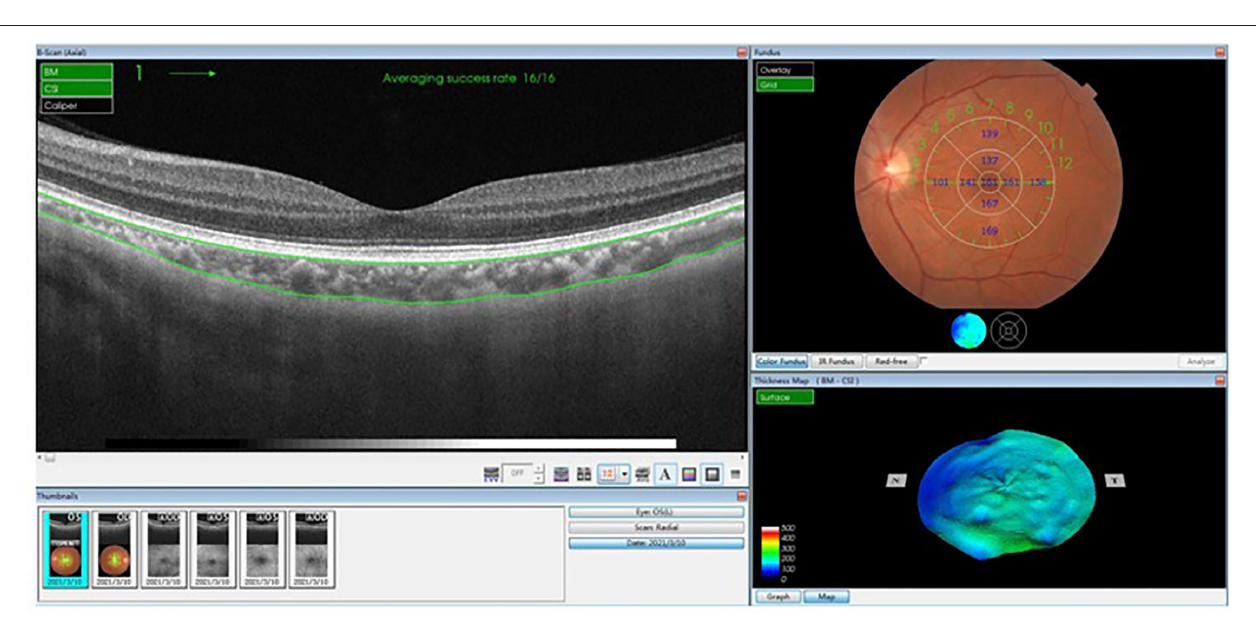
FIGURE 5 | The ETDRS automatic segmentation method using TOPCON advanced boundary segmentation-TABS software. An ETDRS map is generated automatically, which can be corrected manually. The ETDRS grid is composed of three concentric circles: the diameter of the fovea, parafovea, and perifovea are 1, 3, and 6mm, respectively. The average choroidal thickness in the central circular and the eight sectors of superior, inferior, nasal, and temporal areas can be calculated, respectively. ETDRS, Early Treatment Diabetic Retinopathy